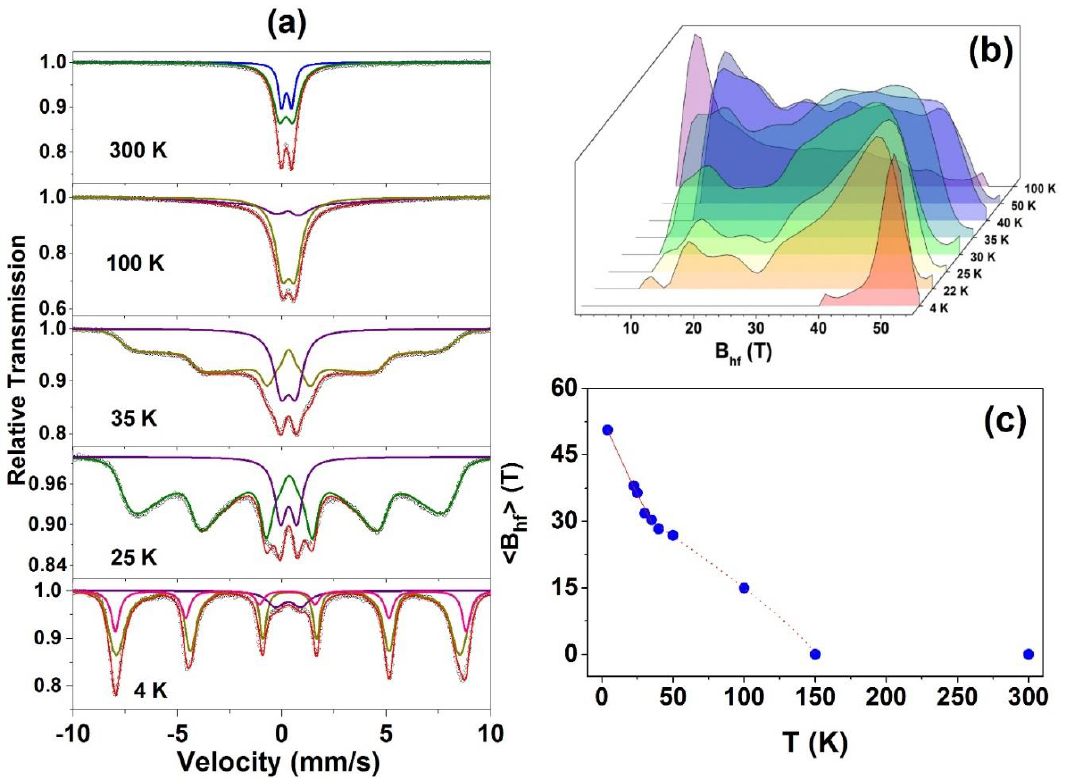
Figure 8. Room temperature and low temperature Mössbauer spectra taken with | Vmax | = 10 mm / s for the Zn 0.95 Fe 0.05 O ( a ), all the Bhf distributions ( b ), and < Bhf > versus temperature for this sample ( c ).